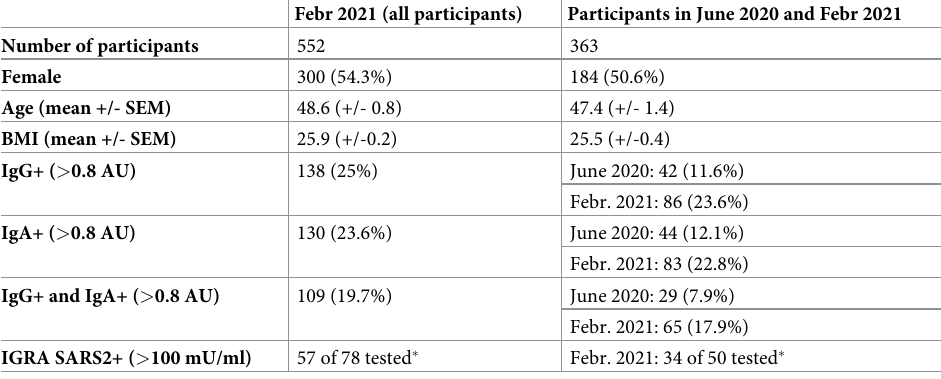
Table 1. Cohort composition. � Participants with a previous positive test for SARS-CoV-2 (PCR or antigen) were selected for quantification of